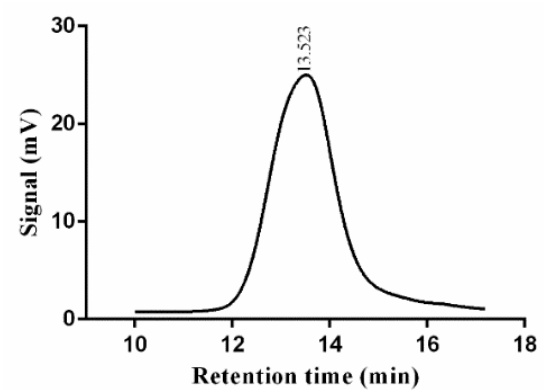
Figure 3. Molecular weight determination of the EPS from Lpb. plantarum NMGL2 by gel permeation chromatography.